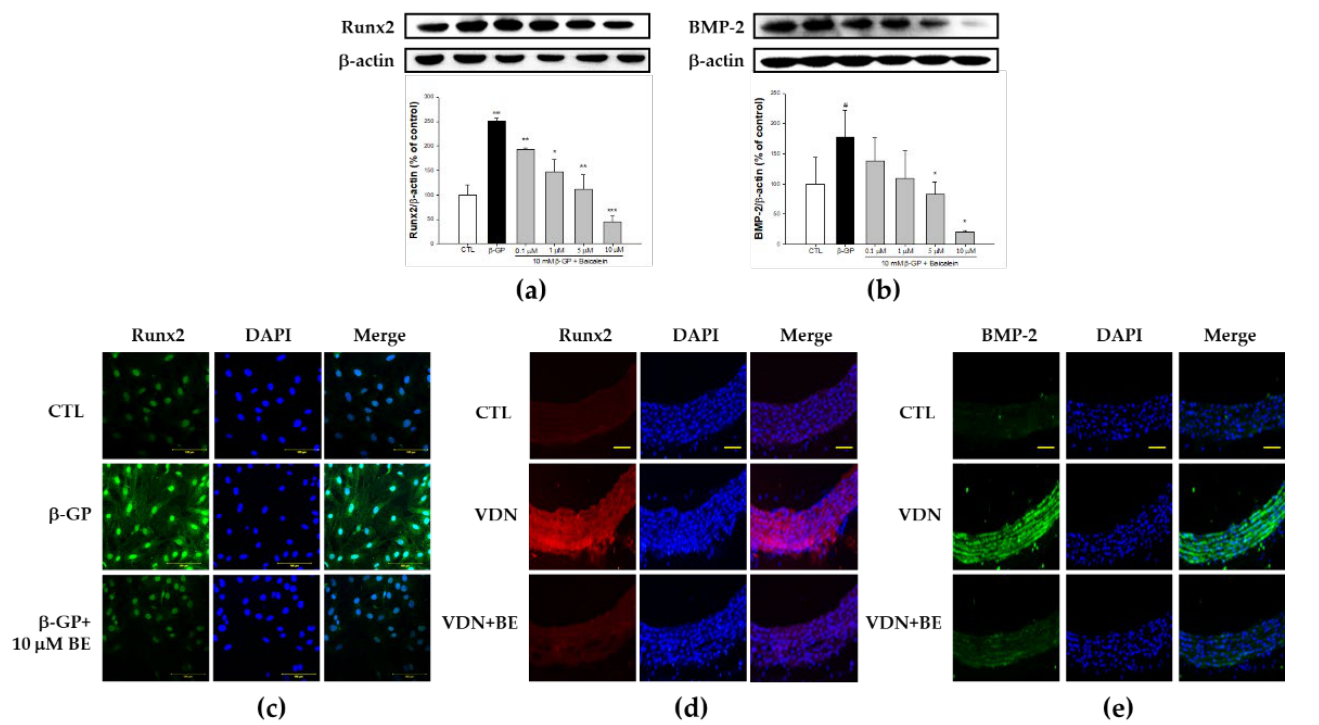
Figure 4. Baicalein suppresses the expression of osteochondrogenic-related proteins Runx2 and BMP-2 in rat VC. Western blots for ( a ) Runx2 protein and ( b ) BMP-2 protein. ( c ) The immunofluorescence detection of Runx2 protein using confocal microscope (200 × ) of primary rat VSMCs. The cells were pretreated with 10 µ M baicalein for 1 h before addition of 10 mM β -GP-induced calcification for 48 h. Bar shows 100 µ m. The immunofluorescence detection of ( d ) Runx2 and ( e ) BMP-2 proteins using confocal microscope (400 × ) in SD rat thoracic aorta tissue. Counterstaining of nuclei with DAPI in blue was merged into all images. Bar shows 25 µ m. All values are presented as mean ± SEM. # p < 0.05; ### p < 0.001 vs. control group (untreated VSMCs); * p < 0.05; ** p < 0.01; *** p < 0.001 vs. the β -GP group.